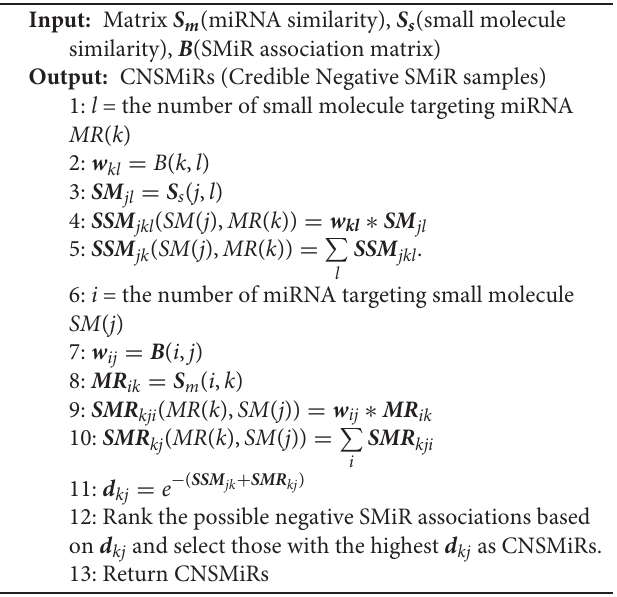
Algorithm 1: Credible negative SMiR association sample extraction